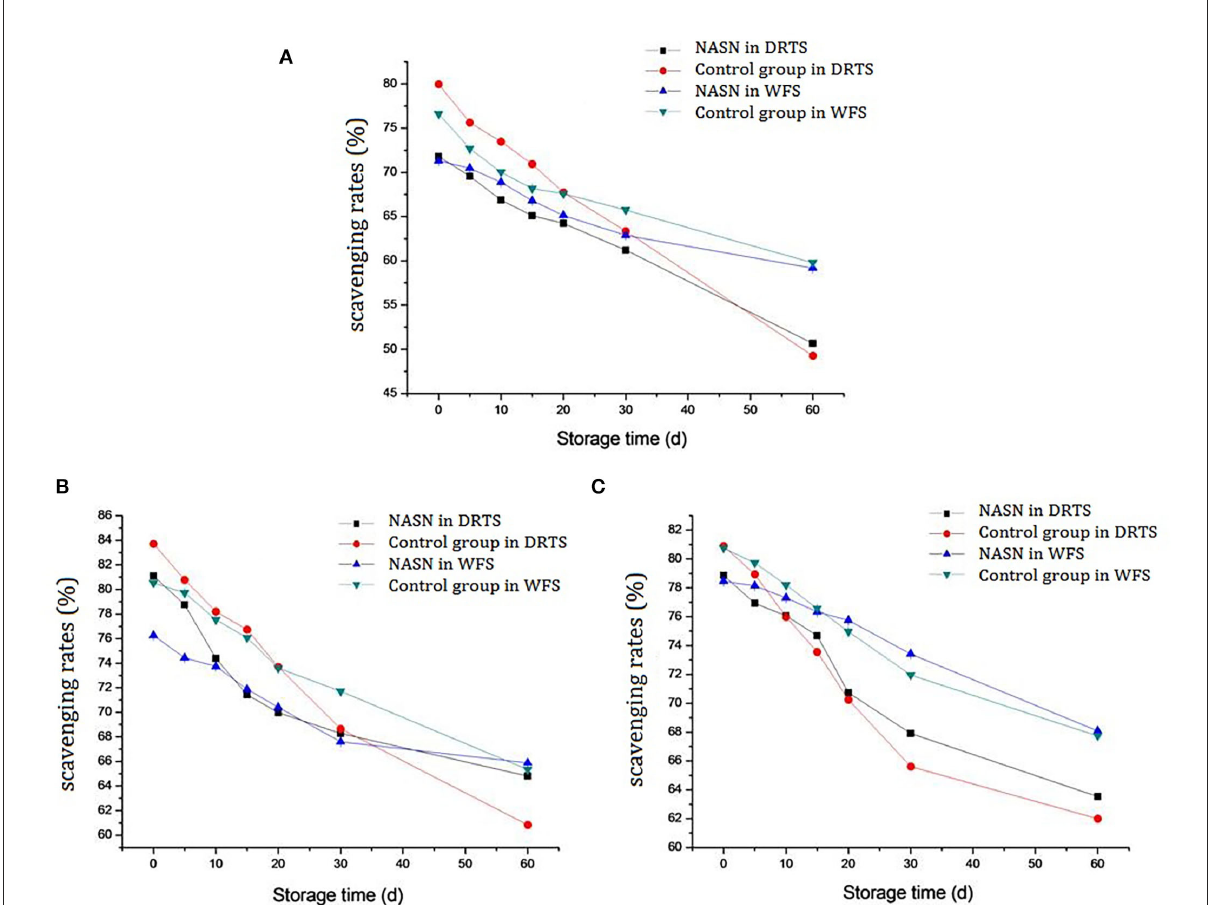
FIGURE7 Free radical scavenging rate changing of curcumin (A) , TP (B) , and lycopene (C) in NASNs and the control group in the condition of DRTS and